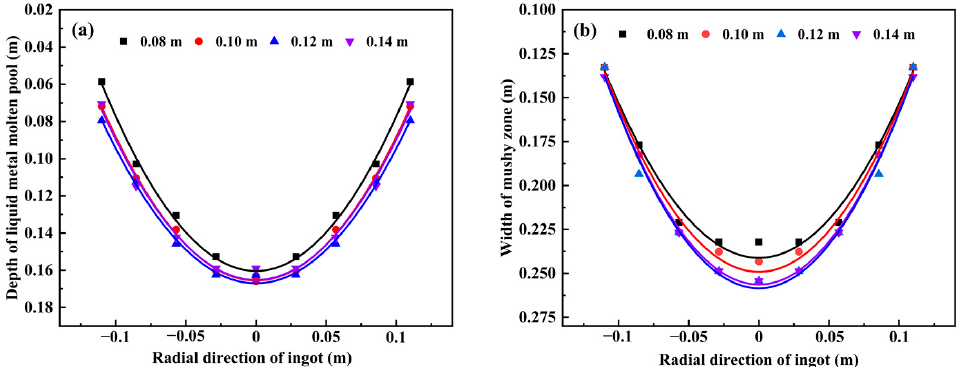
Figure 7. Change of metal pool depth ( a ) and mushy zone width ( b ) along radical direction with varying slag thickness.